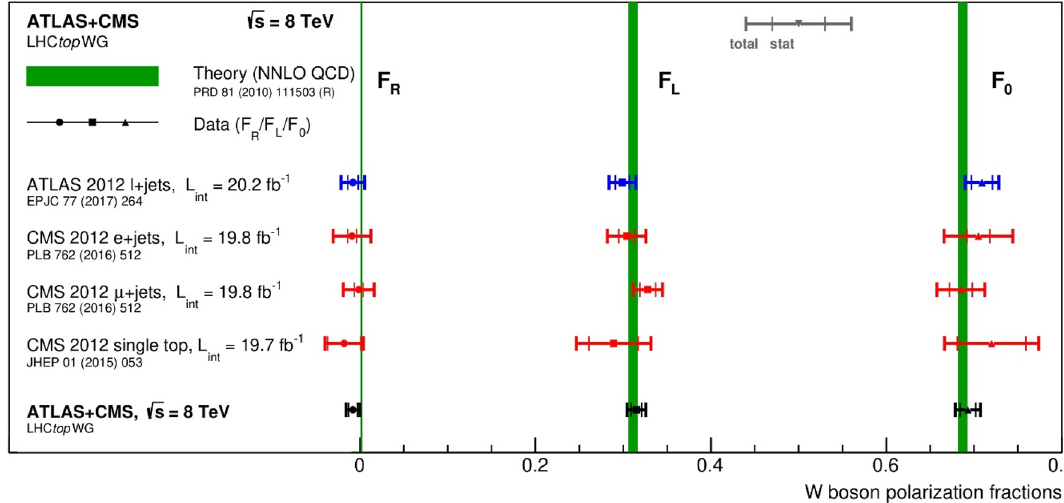
Figure 2 . Overview of the four measurements, as well as the results of the combination. The inner and outer error bars correspond to the statistical and the total uncertainties, respectively. The inner bars for the combination include also the background determination uncertainties. The vertical solid line indicates the predictions of NNLO QCD calculations